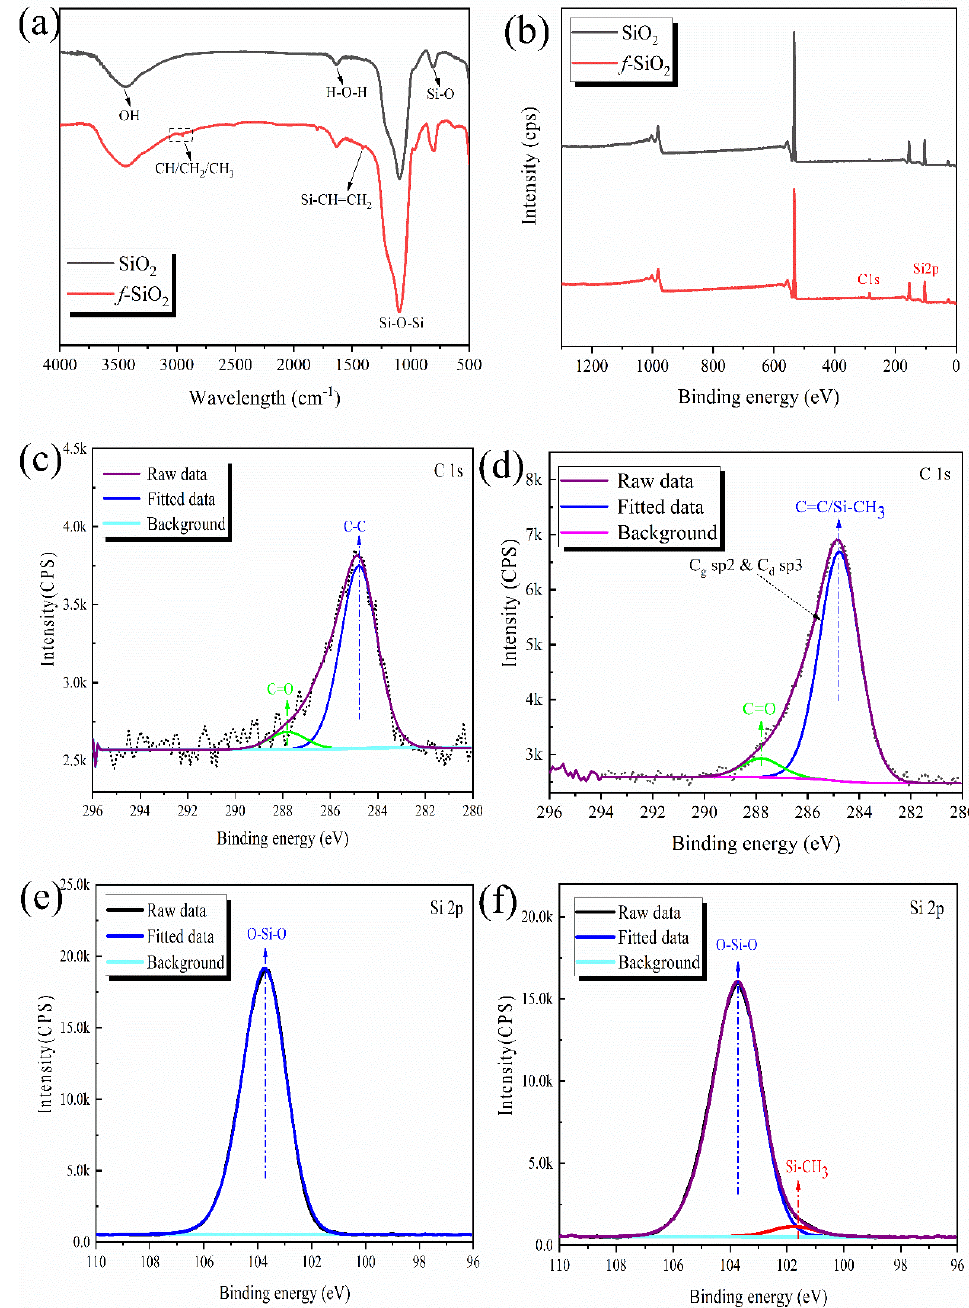
Figure 2. ( a ) FT-IR spectra and ( b ) wide-scan XPS spectra of SiO 2 particles; high-resolution XPS spectra: ( c , d ) C1s peaks of f -SiO 2 and SiO 2 , respectively; ( e , f ) Si 2 p peaks of f -SiO 2 and SiO 2 , respectively.